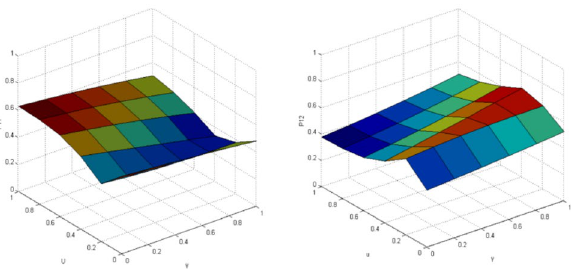
Figure 8. Probability of the target vehicle pass (left:P11)/yeild (right:P12) when knowing that interact vehicle intends to pass (t = π/2).